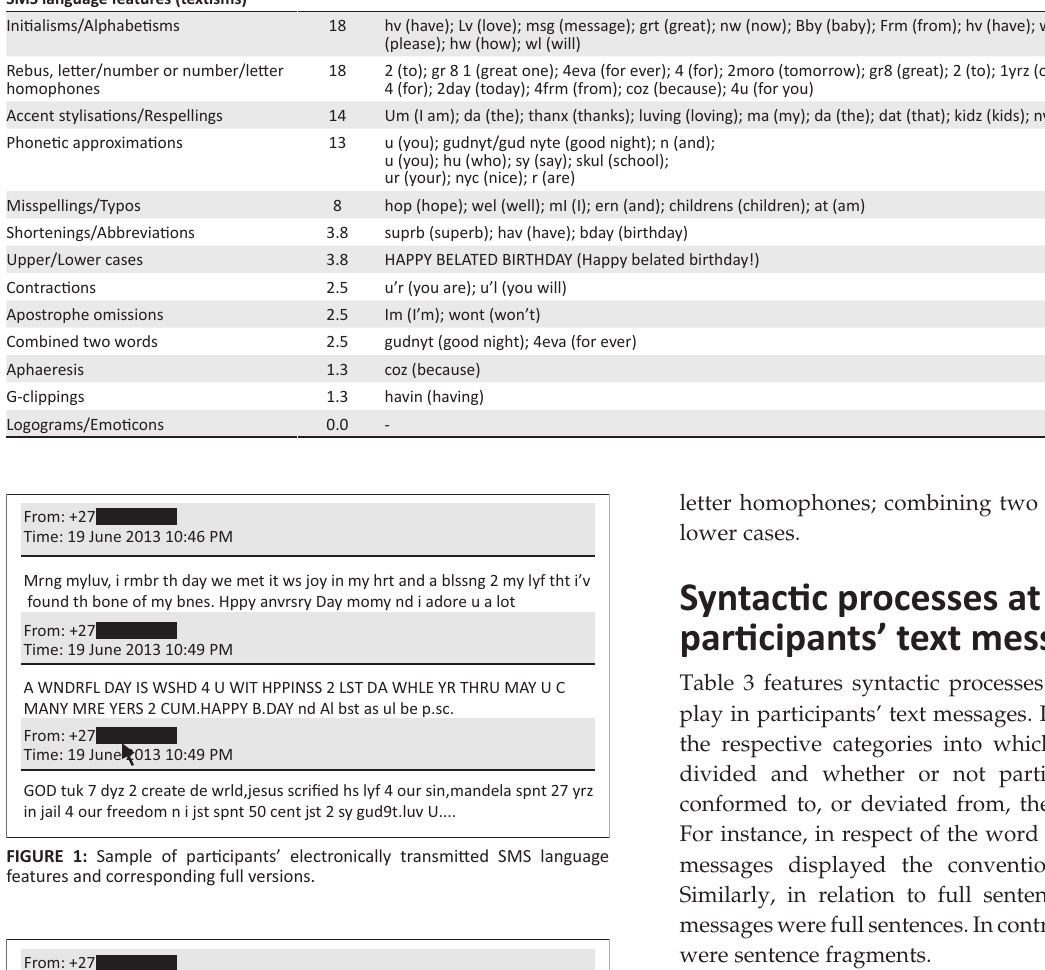
TABLE 1: Participants’ transcribed SMS language features and corresponding full versions. A typology of participants’ transcribed SMS language features